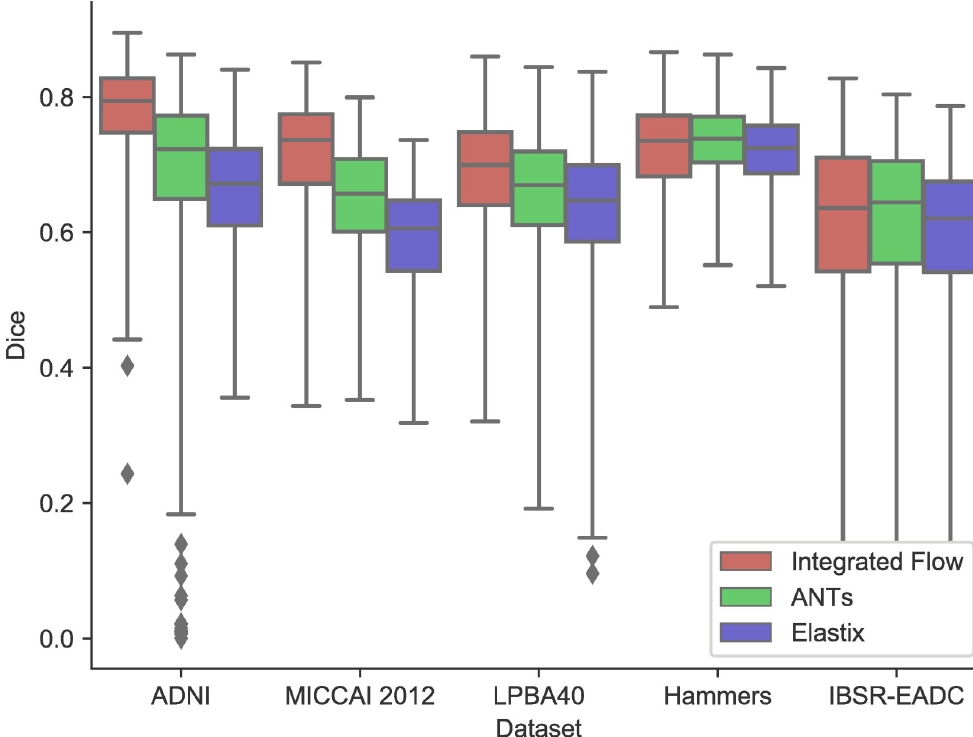
Fig 9. A box and whisker diagram of registration results in Dice coefficients on five datasets for three registration methods, ANTs SyN, Elastix and the integrated flow (our method).